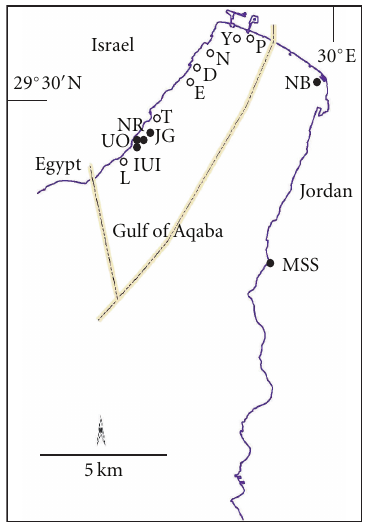
Figure 1: The study sites along the coasts of the northern tip of the Gulf of Aqaba (Red Sea). The young coral community sites are marked with an empty circle: Peace lagan: P, three stations; (Y) Yacht Marina, two stations; (N) Naval base, one station; (D) Dekel beach, three stations; (E) Eilat port, one station at the Dolphin Reef 100m south of the port main quay; (T) (Tur-Yam) old marina, one station; (L) lighthouse beach, three stations. The natural reefs are marked with a filled circle: (MSS) Aqaba’s Marine Science Station; (NB) the north beach of Aqaba; (NR) northern part of Eilat’s marine nature reserve; (JG) the Japanese Gardens at the southern part of Eilat’s nature reserve (north of the underwater observatory); (UO) knolls south of the underwater observatory; (IUI) The Inter- university Institute for Marine Sciences in